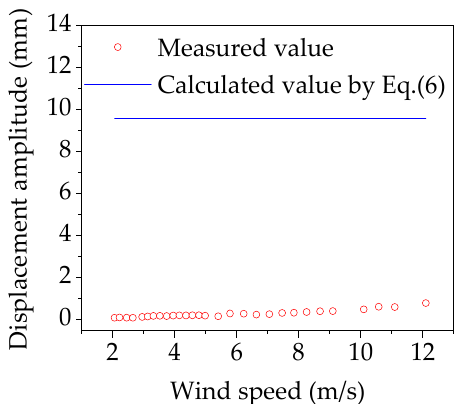
Figure 7. Comparison between the calculated value in the code and the measured value.